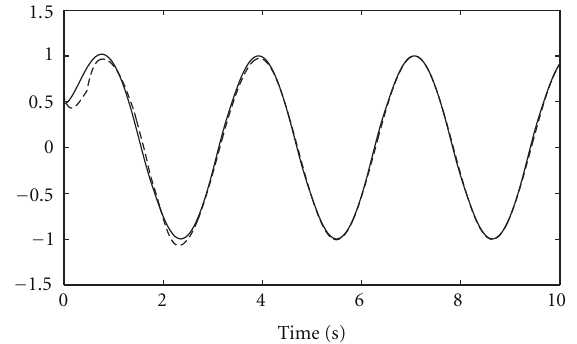
Figure 5: Output y ( t ). dashed line for the multiple model case ( N = 4) as in [7], solid line for the multiple identification model developed in this paper.